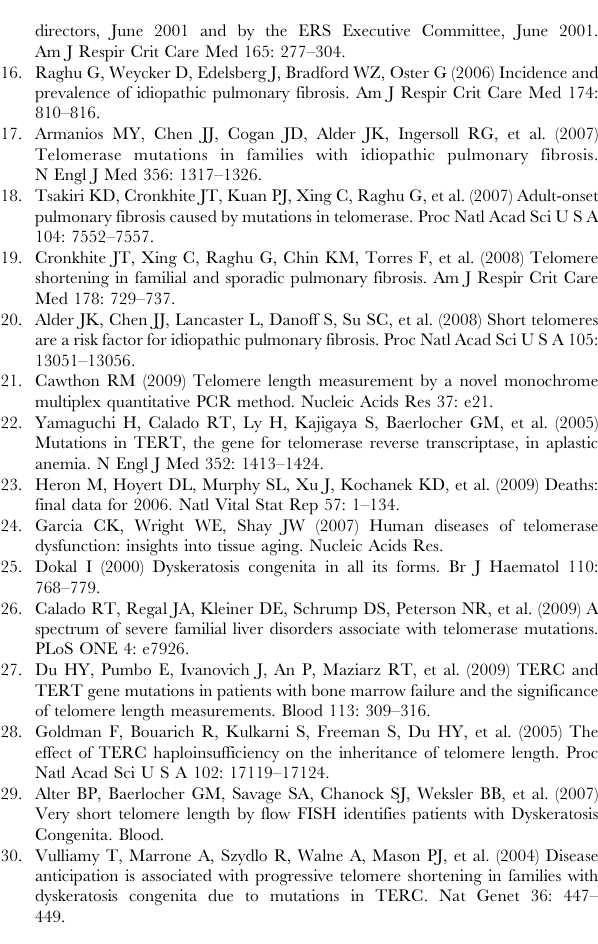
Figure S1 Evaluation of novel rare TERT mutations. (A) Sequence electropherograms of PCR products amplified from genomic DNA of individuals heterozygous for mutations in TERT . Wild-type (wt) and mutant cDNA sequences are listed directly below the tracings. Heterozygous missense mutations are indicated at the positions marked by the short arrows. (B) Amino acid alignment of the TERT sequences of Homo sapiens (human), Macaca mulatta (monkey), Canis familiaris (dog), Bos taurus (cow), Mus musculus (mouse), Rattus norvegicus (rat), Gallus gallus (chicken), Xenopus laevis (frog), Schizosaccharomyces pombe (yeast), and Arabidopsis thaliana (plant). (C) Relative telomerase activity of TERT mutations as measured by the telomere repeat amplification protocol (TRAP) assay are calculated as a ratio of the intensity of the sample’s telomerase products to that of an internal control band and normalized to wild-type activity. Error bars represent the SD of duplicate experiments. Parallel reactions using [ 35 S]methionine were run on a sodium dodecyl sulfate-polyacrylamide gel to confirm equal expression of the TERT wild-type and mutant proteins.